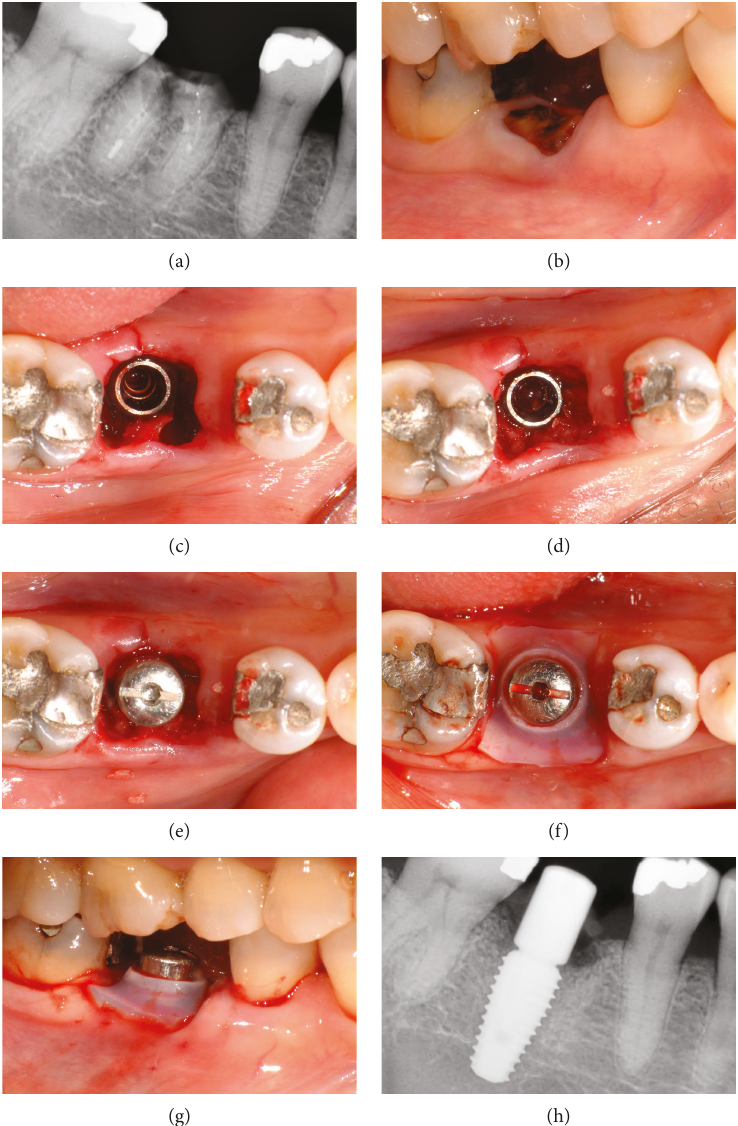
Figure 2: (a) Periapical radiograph of tooth 46 from the initial examination. (b) Buccal view of tooth 46 at the initial examination. (c) Implant inserted into interradicular septum. (d) Clinical condition after gap fi lling with autologous particulate bone. (e) Clinical condition after the installation of a cylinder-type healing abutment. (f) Occlusal view after the application of silicone cap on healing abutment. (g) Buccal view after the application of silicone cap on healing abutment. (h) Periapical radiograph immediately after